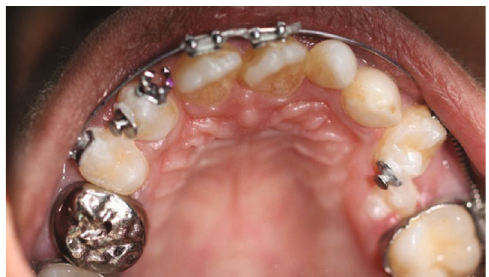
Figure 5: Intraoral photograph shows cemented crown and molar bands.